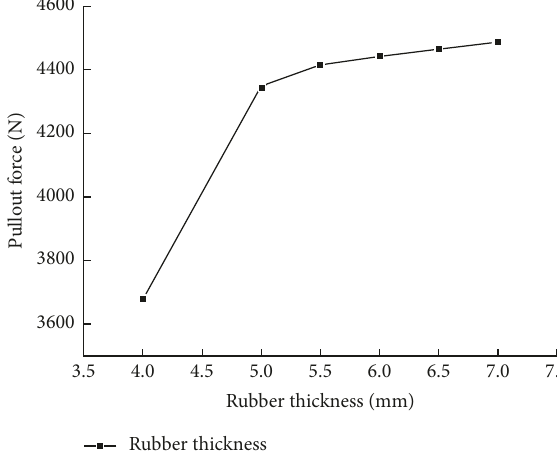
Rubber thickness Figure 11: The change in pullout force with different rubber